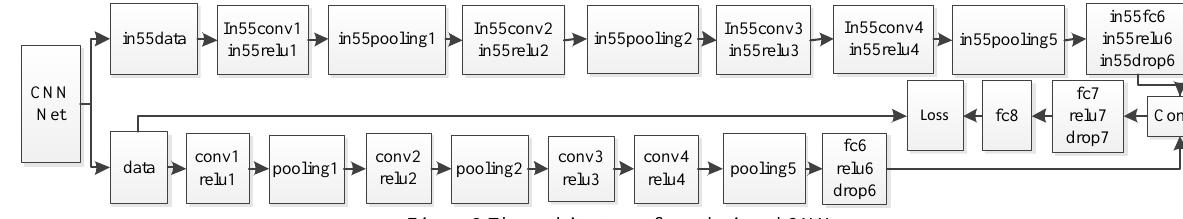
Figure 3 The architecture of our designed